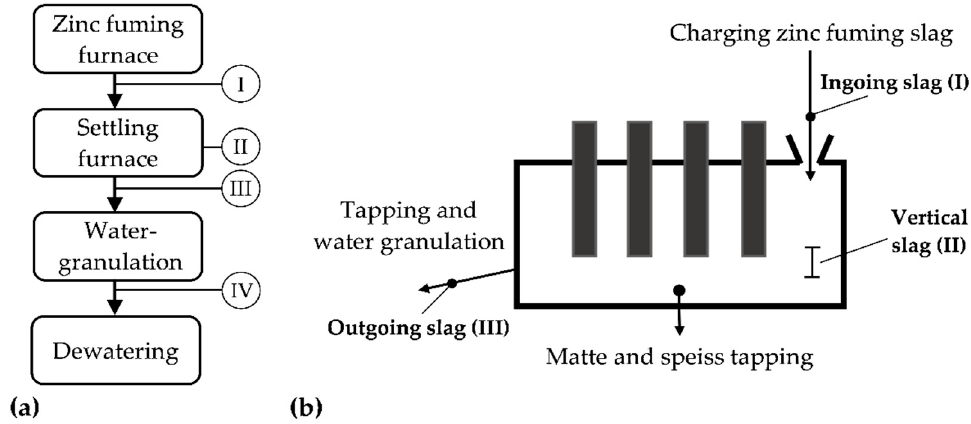
Figure 1. ( a ) Flowsheet of the ESF slag with the sample points for the ingoing (I), vertical (II), outgoing (III), and granulated (IV) slag; ( b ) Schematic of the electric settling furnace.